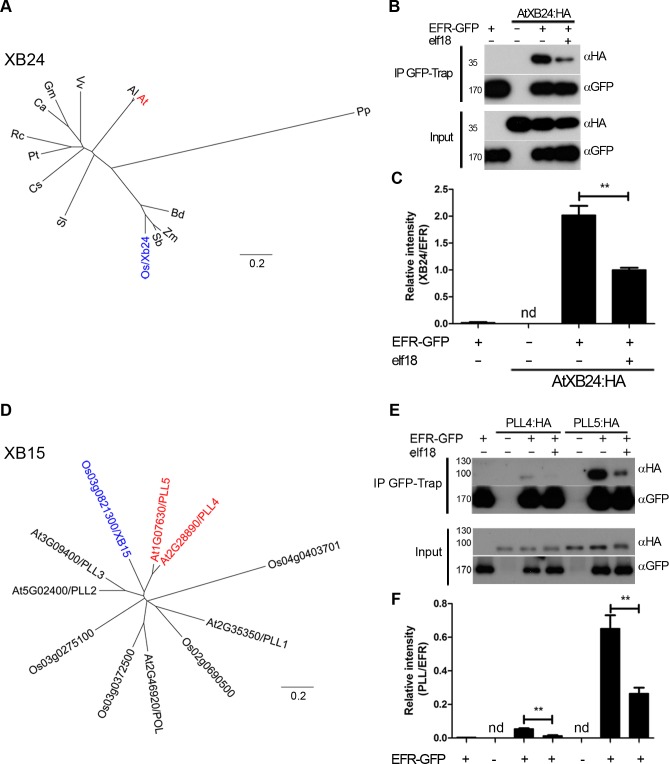
EFR associates dynamically with the A. thaliana orthologues of OsXB15 and OsXB24 in planta.A,D. Phylogenetic analysis of XB24 and XB15 in rice and Arabidopsis. OsXB24 is a single gene in all plant genomes analyzed. OsXB15 most closely relates to AtPLL4 and AtPLL5. Distance trees are based on protein sequences aligned with MUSCLE (produced with PHYLIP, using PROTDIST and NEIGHBOR). Accession numbers for sequences used can be found in S4 Table and alignments in S1 and S2 Figs. B,E. Co-immunoprecipitation of AtXB24 or AtPLL4 and AtPLL5 (A. thaliana orthologues of OsXB15) with EFR. EFR:GFP and HA-tagged AtXB proteins were co-expressed transiently in N. benthamiana. Leaves were treated with 100 nM elf18 (+) or mock treated with water (−) for 10 min. Immunoprecipitation (IP) was performed with GFP-Trap agarose beads. Western blots were performed with HRP-conjugated anti-GFP or anti-HA. Experiments were performed at least three times with similar results. C, F. Quantitation of data presented in B and E. Values are the average ratio of AtXB24:HA, PLL4:HA or PLL5:HA to EFR:GFP ±SE (n = 3). Asterisks indicate statistical significance of mock compared to elf18 treated, p < 0.01 (Student’s t-test). nd is not determined.